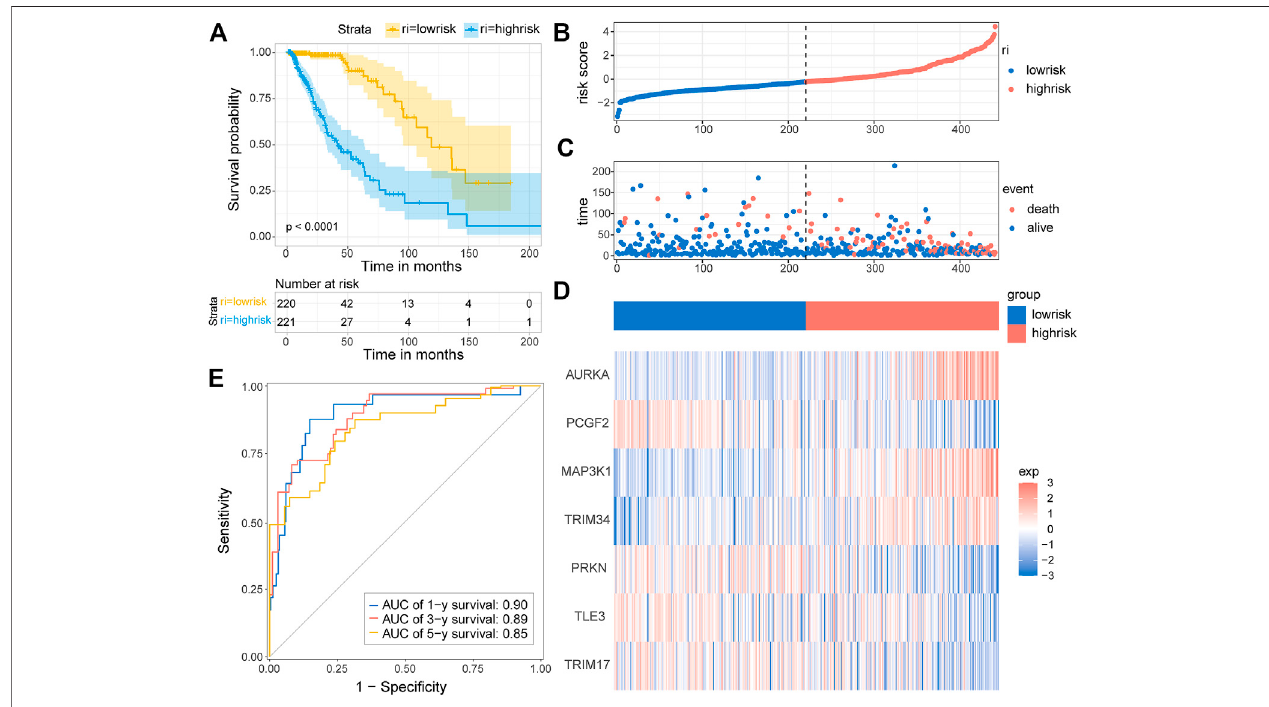
FIGURE5| DistributionandprognosticanalysisoftheE3RGprognosticsignatureintheTCGAcohort. (A) Kaplan – Meiercurvesofoverallsurvivalforthepatientsin the high-risk group and the low-risk group of the TCGA cohort. The distribution plots (B) , corresponding survival status (C) , and the expression of the seven signature genes (D) in the TCGA cohort. (E) Time-dependent ROC curve validation of the predictive capacity of the risk signature in the TCGA cohort.